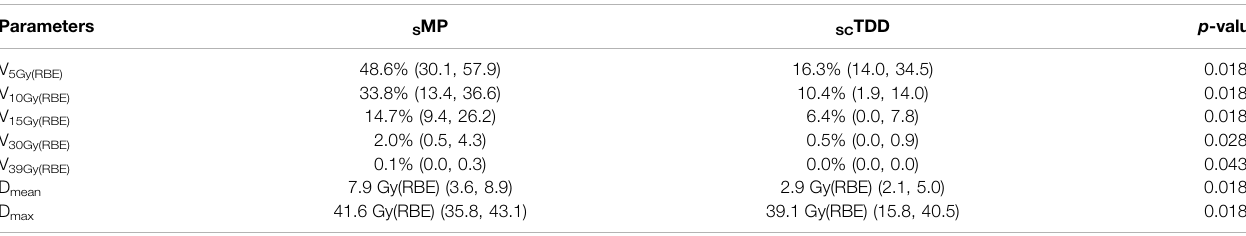
TABLE 3 | Comparison of dosimetric characteristics for contralateral oral mucosa between the S MP and SC TDD.